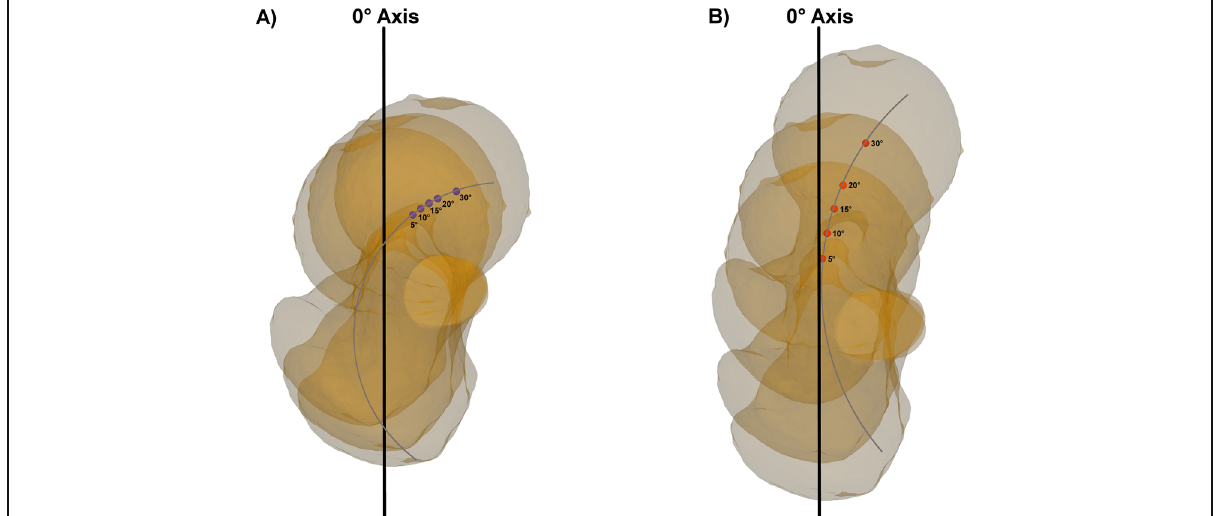
Fig. 6 Effect of decreased postoperative sagittal mechanical leg axis deviation with increased mal-angulation in subtrochanteric procedures. a Subtrochanteric rotational osteotomy in Model 2 using an osteotomy plane with + 5° sagittal mal-angulation. Marked is the sagittal projected 0° axis in black and the femoral head centers for every step of rotation in purple. In grey schematically marked is the relative circle of movement of the femoral head center. b Subtrochanteric rotational osteotomy using an osteotomy plane with + 30° sagittal mal-angulation. In red the femoral head centers for ever step of rotation. Compared to Fig. 6a, the relative circle of movement of the femoral head center is flatter and more in line with the 0°